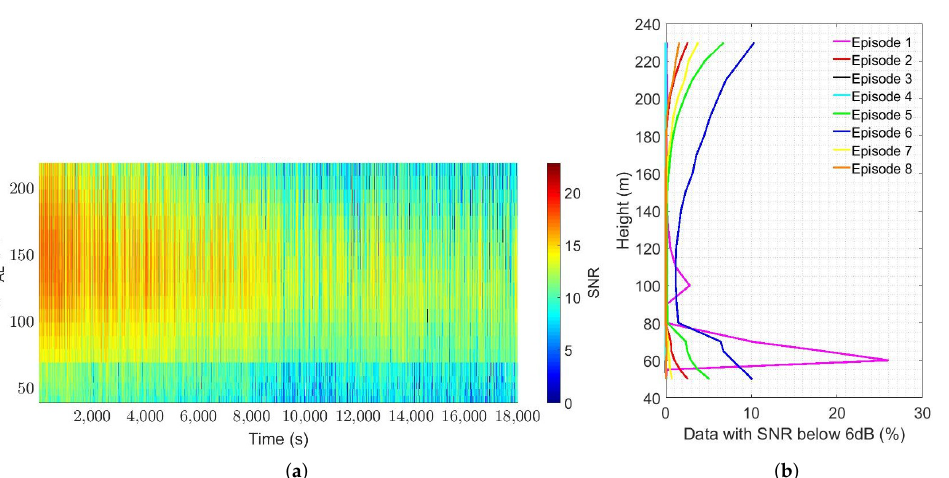
Figure 6. ( a ) Time series of signal-to-noise ratio (SNR) values measured for different heights above the lidar (h AL ) for the measurements taken on 4 December 2019. The line at 70m, which distinguishes two parts at the THI plot, is due to system design and does not affect the wind retrieval. ( b ) Fraction of wind speed data points with SNR values lower than 6dB at each measurement height during a Bora episode, calculated with respect to all data points at the corresponding